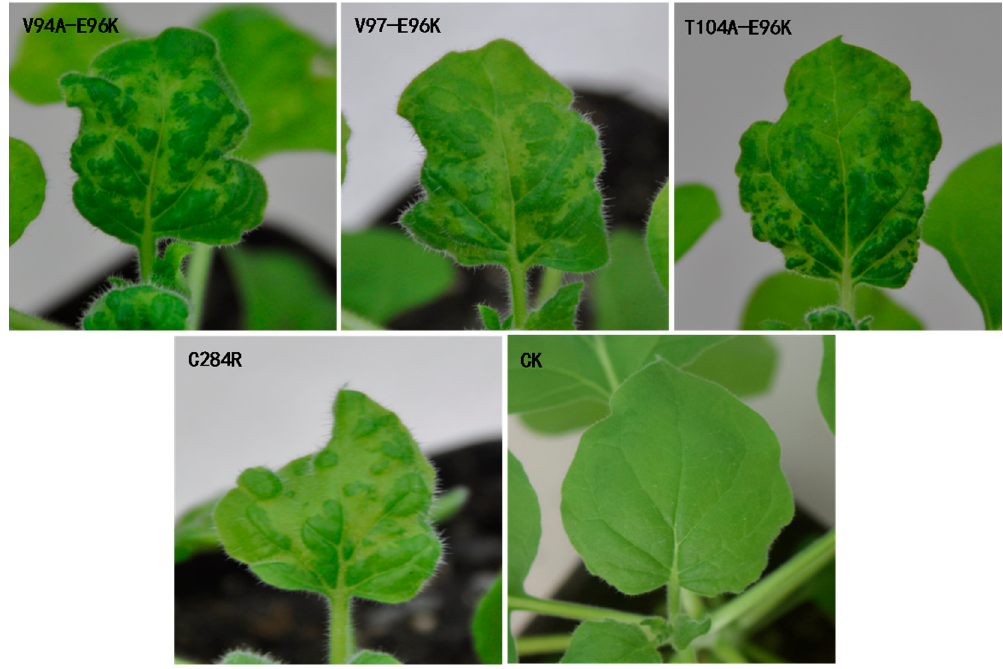
Figure 2. Symptoms of three double mutants V94A-E96K, V97-E96K, and T104A-E96K after inoculation at 10 dpi.